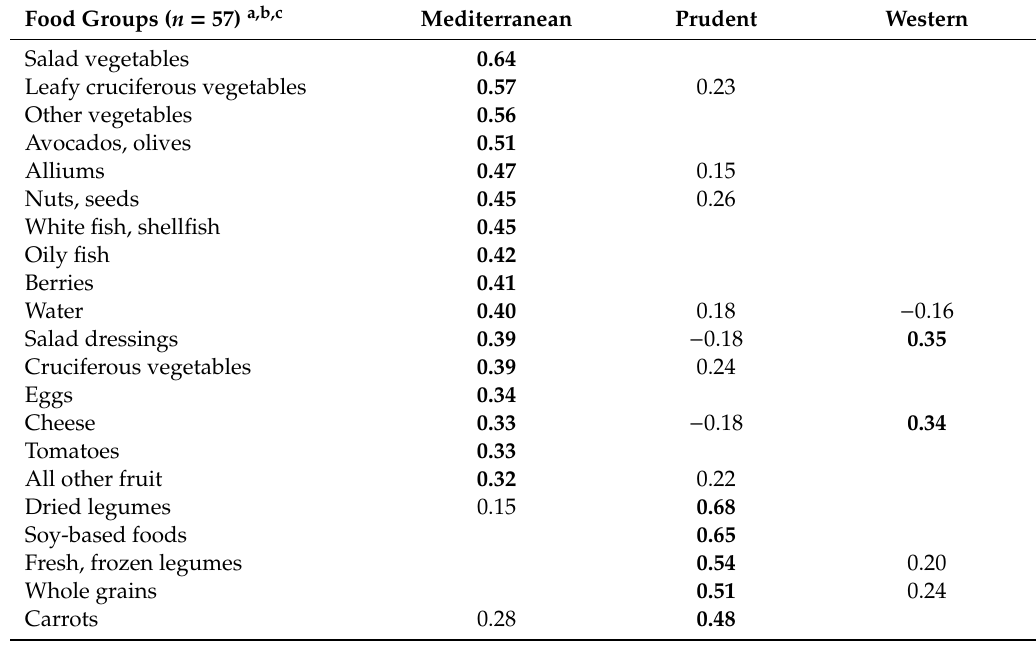
Table 3. Factor loadings for three major dietary patterns identified using a food frequency questionnaire ( n = 367). Food Groups ( n = 57)